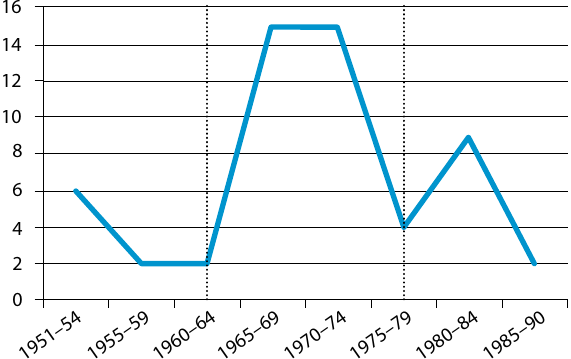
fig. 1. Dynamics of scientific degrees of candidate of architectural sciences obtained by lithuanian architects during the Soviet times. Vertical lines define the period when lithuanian institutions had rights both for training of aspirants and defense of their dissertations (chart by the